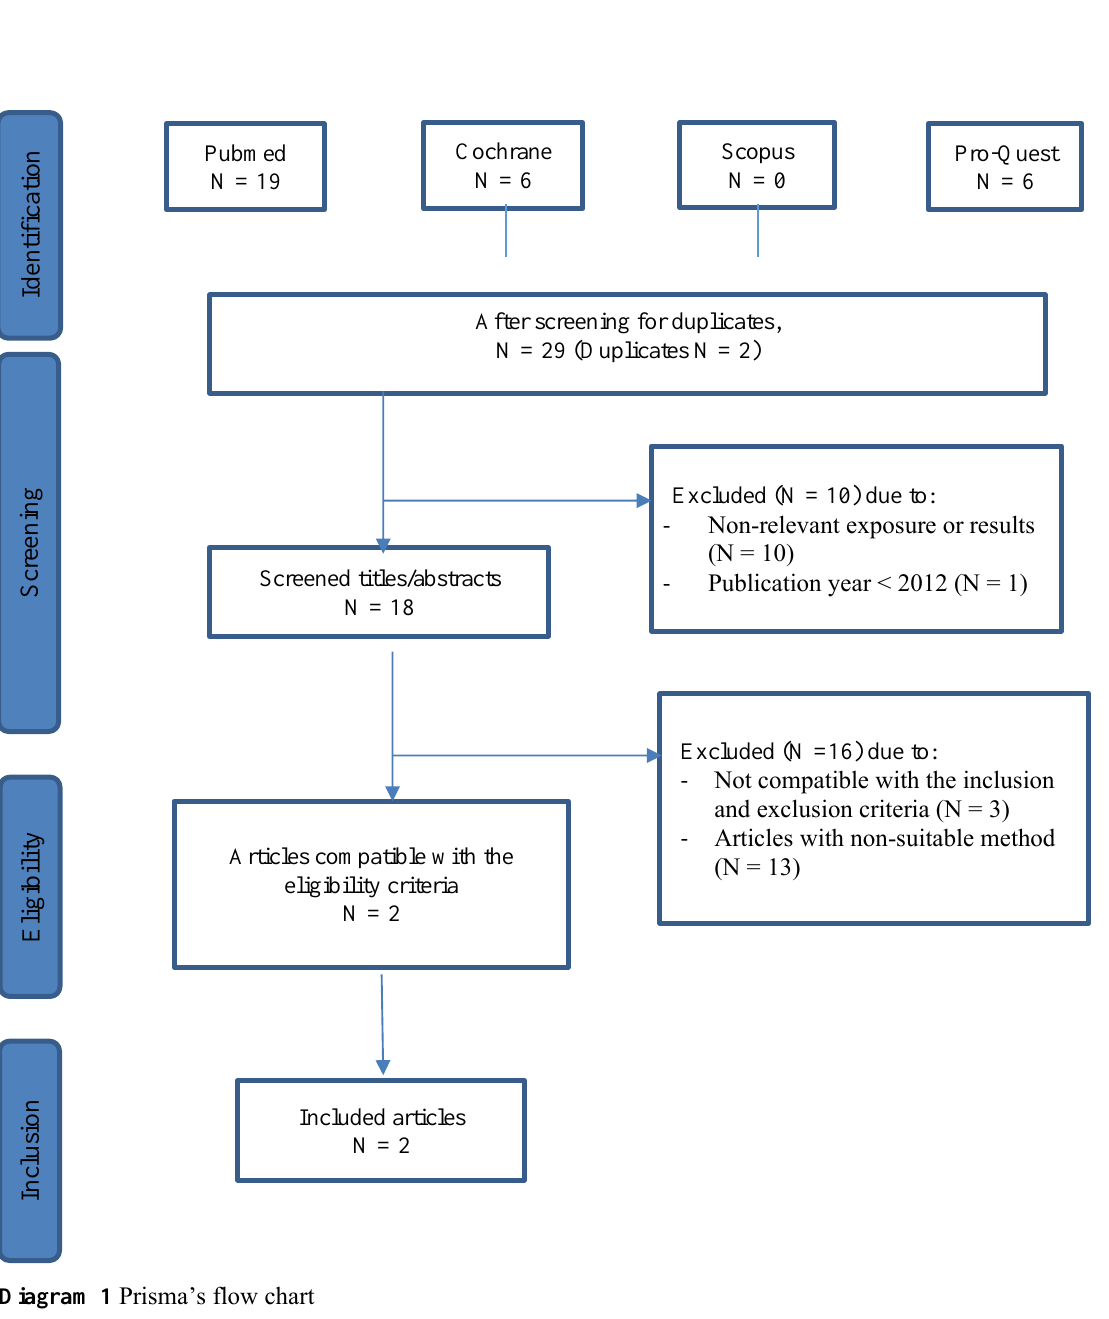
Diagram 1 Prisma’s flow